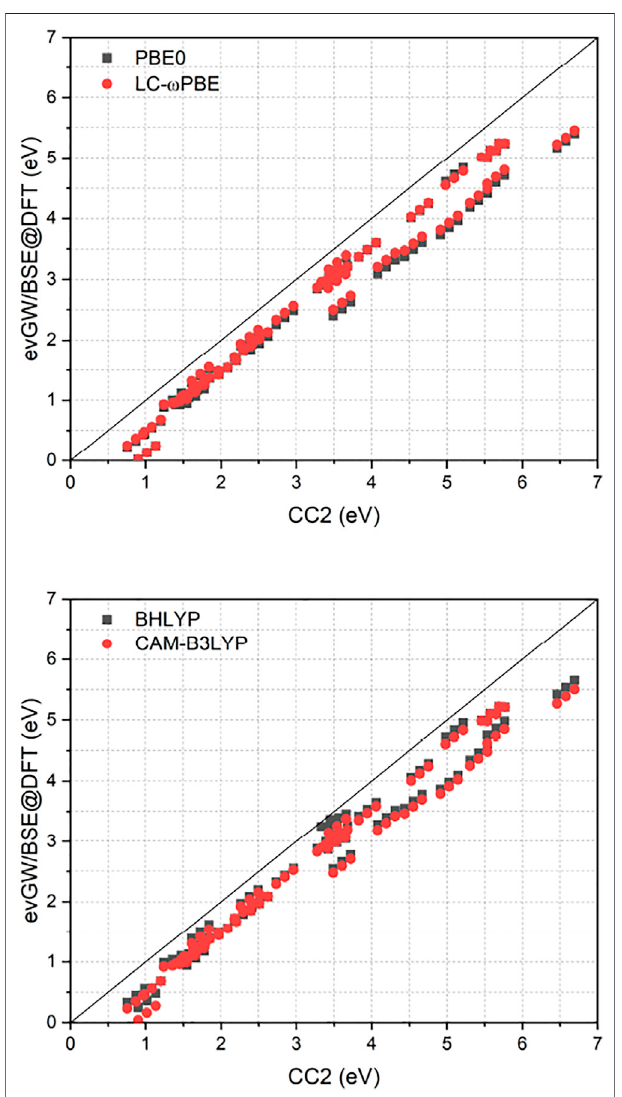
FIGURE 1 | Comparison of excitation energies from the RI-CC2 and ev GW /BSE@DFT methods. ev GW /BSE calculations have been performed using eitherPBE0,LC- ω PBE,BHLYP orCAM-B3LYP spinors.Allcalculations used the def2-TZVP basis set. All values in eV.